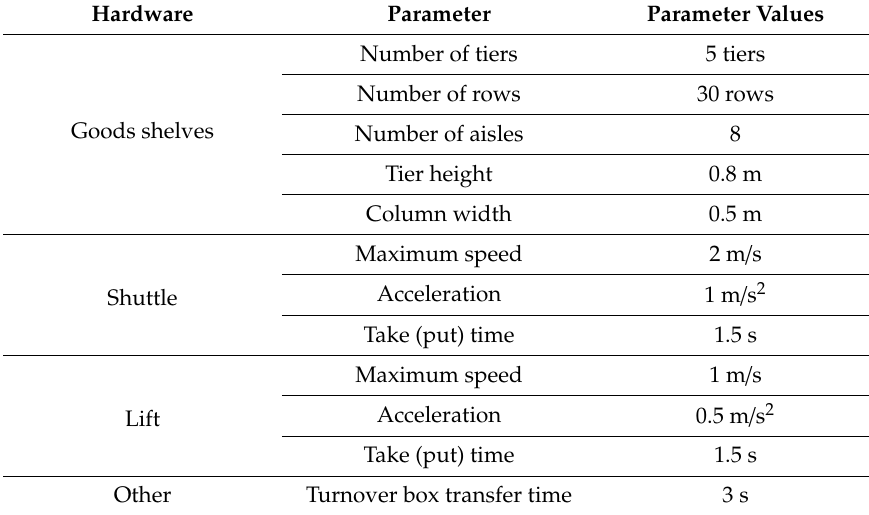
Table 2. System layout and device parameter.